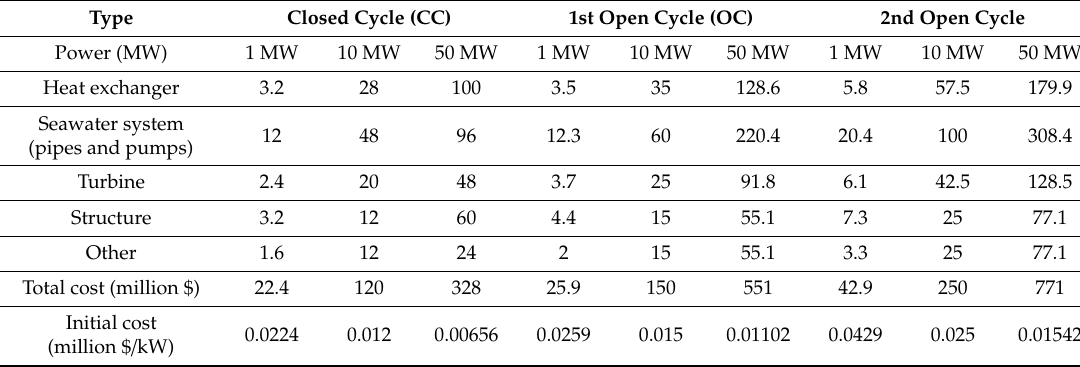
Table 2. Initial investment cost for OTEC